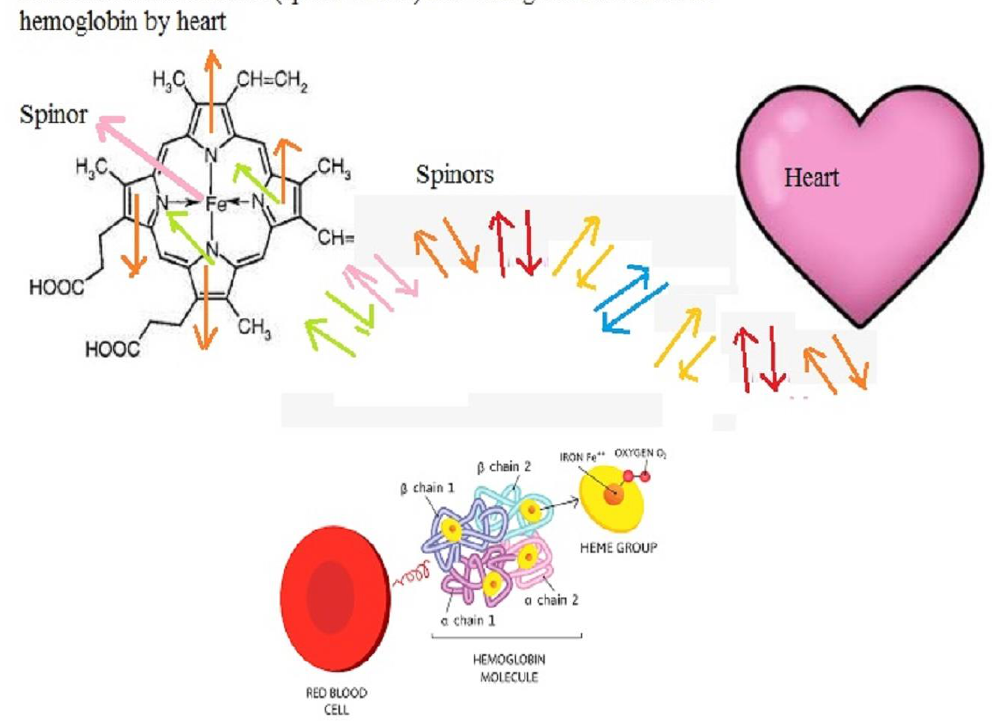
Figure 4. Induction of information (spinor waves) into multi-gonal molecules of hemoglobin by the heart—a